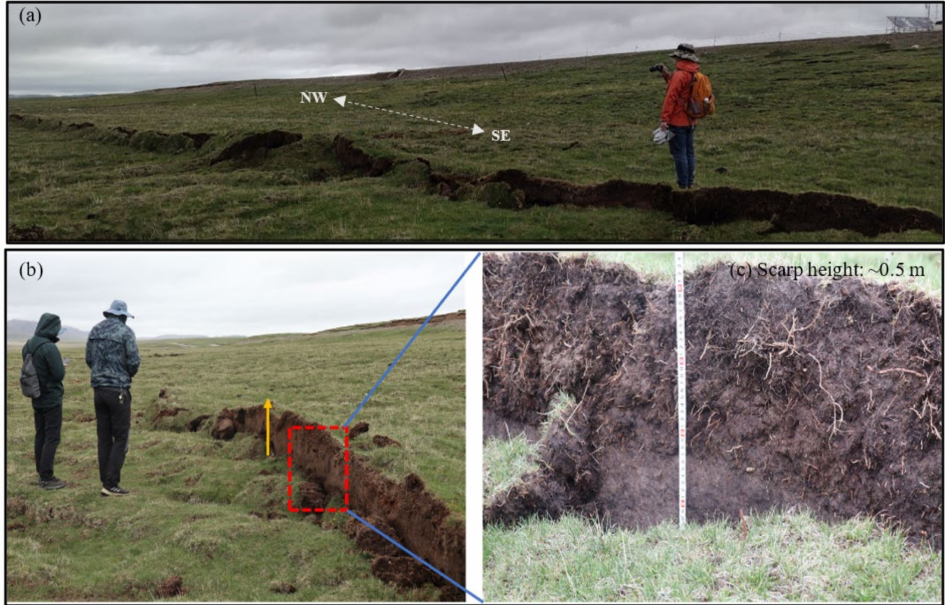
Figure 10. The surface rupture along the Changmahe fault ( a ). The found fault outcrop ( b ) with a scarp height of 0.5 m ( c ). The white arrow shows the surface rupture direction of the Changmahe fault. The location of the field investigation is indicated by the red circle in Figure 11b.